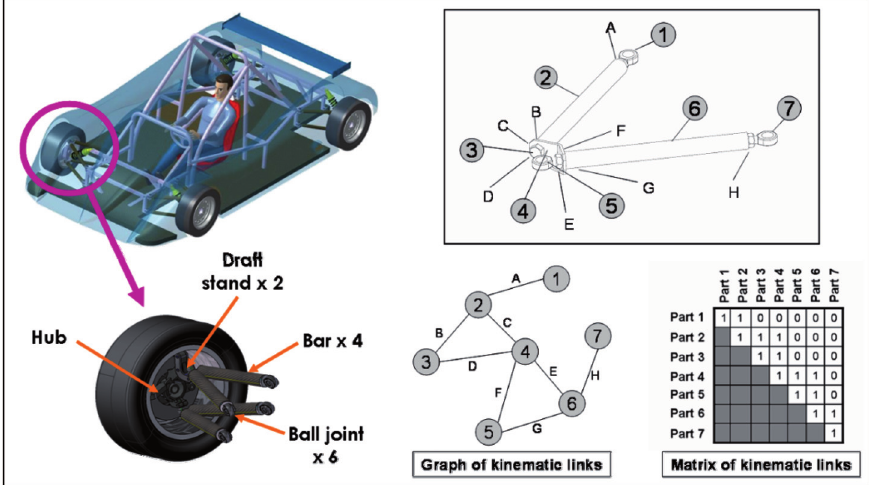
Fig. 4. Ground-link suspension system defined kinematically.